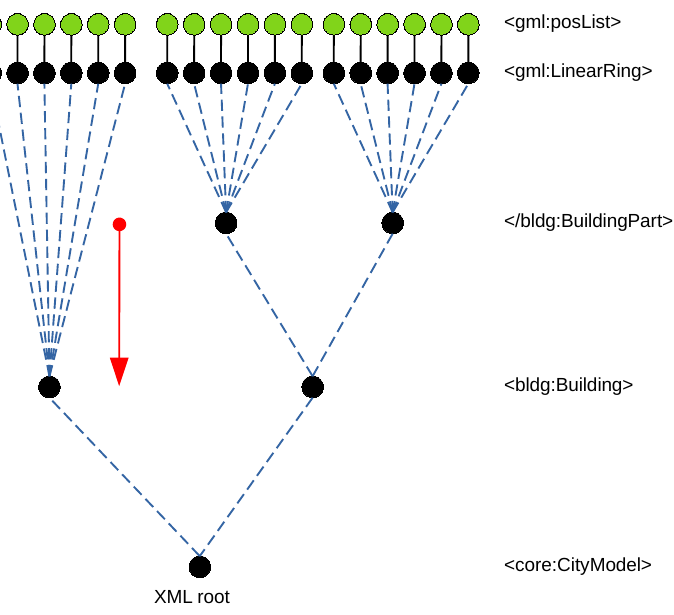
Figure 5. CityGML examples for decomposing an XML based file. If a finer-grained decomposition type does not exist, the next less fine-grained decomposition is used (red